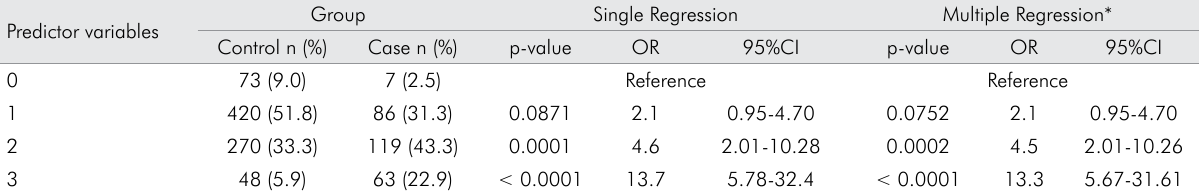
Table 3. Association between the number of predictor variables and painful TMD. Predictor